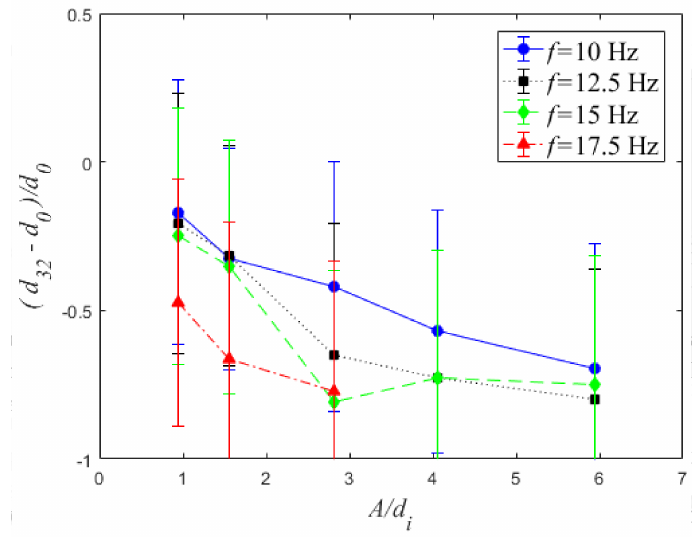
Figure 7. The change in bubble size with vibration scaled versus the Sauter mean bubble size under static conditions ( d 0 ) plotted versus the vibration amplitude scaled with the injector tube diameter ( d i ). Data was acquired at U SG = 5 mm/s at f = 10, 12.5, 15 and 17.5 Hz. It is known that bubble breakup improves mass transfer by increasing the interfacial area ( a